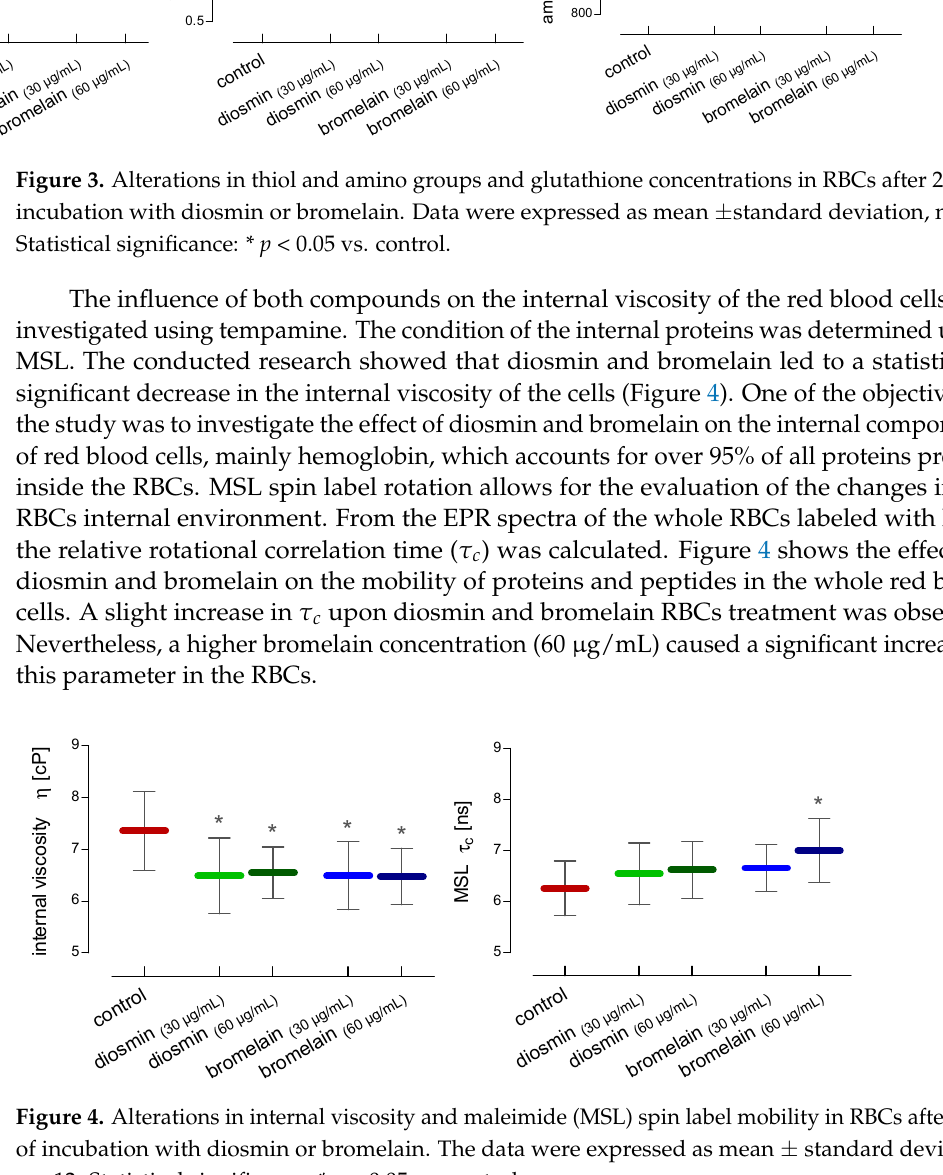
Figure 2. Alterations in the total non-enzymatic antioxidant capacity in RBCs after 24 h of incubation with diosmin or bromelain. The data were expressed as mean ± standard deviation, n = 16.